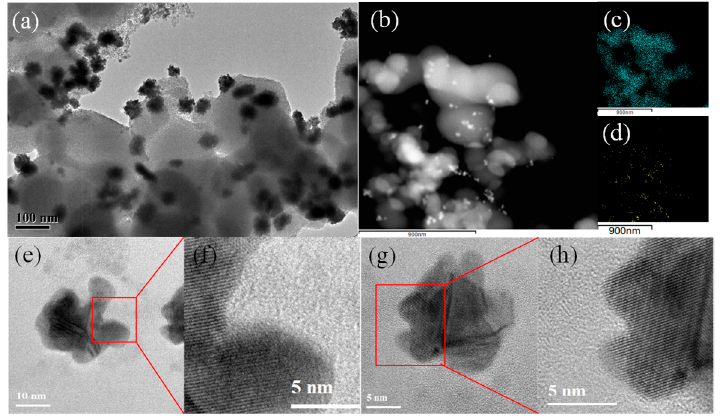
Figure 4. ( a ) The TEM images of AuNCs@a ‐ TiO 2 prepared via electric ‐ field ‐ assisted femtosecond laser liquid ‐ phase ablation the hydrate suspensions of Au 3+ and TiO 2 , ( b , c ) are the HRTEM images; ( d ) The TEM images of AuNSs @a ‐ TiO 2 prepared via electric ‐ field ‐ assisted temporally ‐ shaped femtosecond laser liquid ‐ phase ablation the hydrate suspensions of Au 3+ and TiO 2 ; ( e , g ) The HRTEM images of AuNSs; ( f , h ) are the local FFT transformed images of the corresponding regions of ( e , g ).